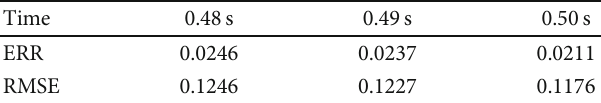
Table 2: Deformation fi tting errors at di ff erent times.